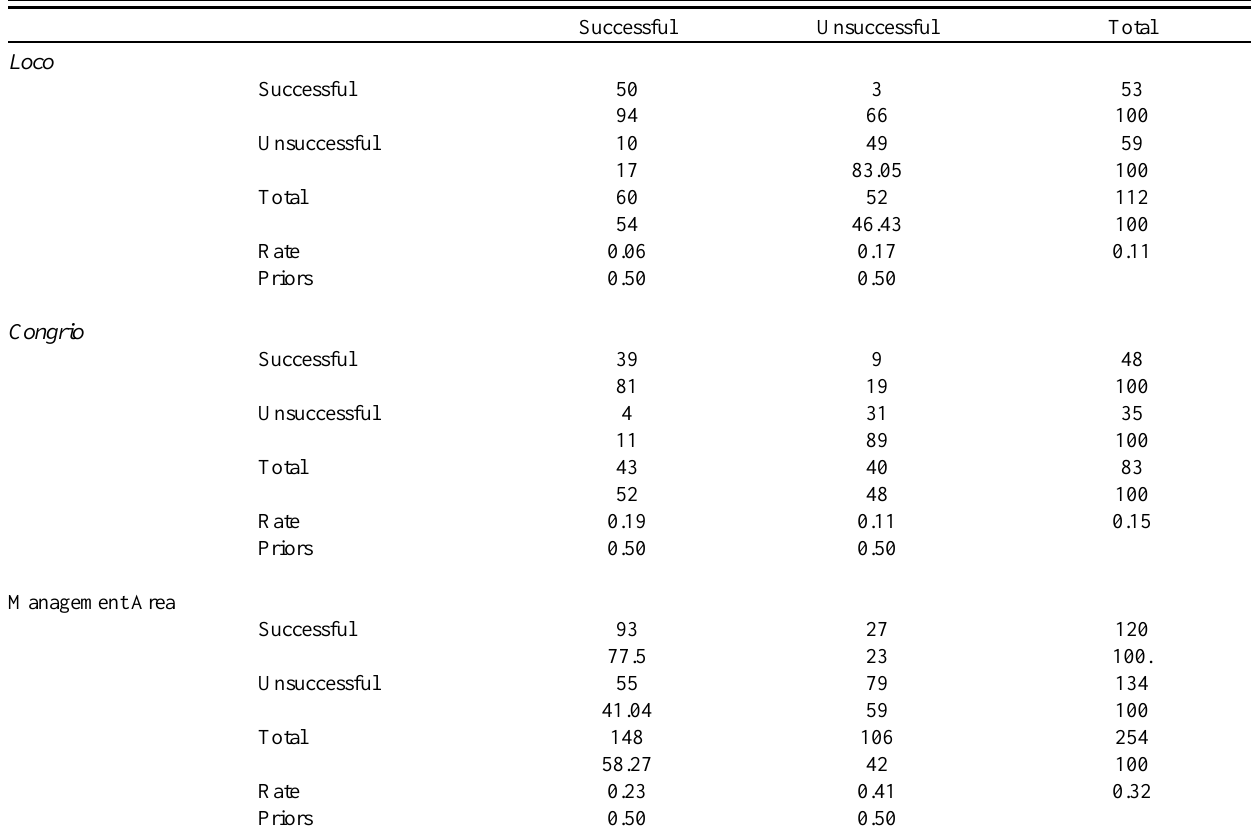
Table 7 . Number of observations and percent classified and error count estimates of successful and unsuccessful groups using stepwise discriminant analysis. Successful Unsuccessful Total Loco Successful